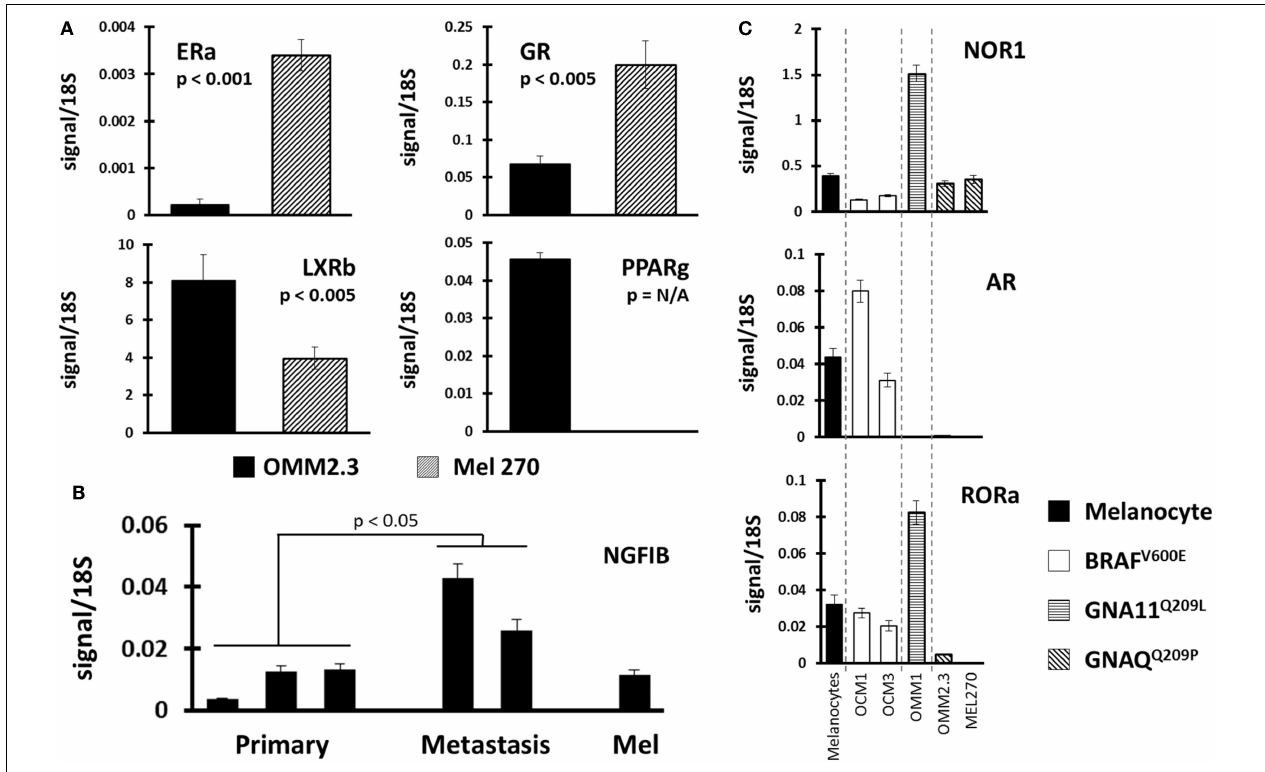
FIGURE 4 | Identification of NR expression patterns within uveal melanoma subtypes . (A) Comparisons were made between replicate data generated from UM cell line pair OMM2.3 (metastasis-derived) and MEL270 (primary-derived) with p -values calculated through a Bonferroni-corrected Student’s t -test. ERa and GR expressions were lost in the metastatic line (top) while LXRb and PPARg expressions were higher in the metastasis (bottom).